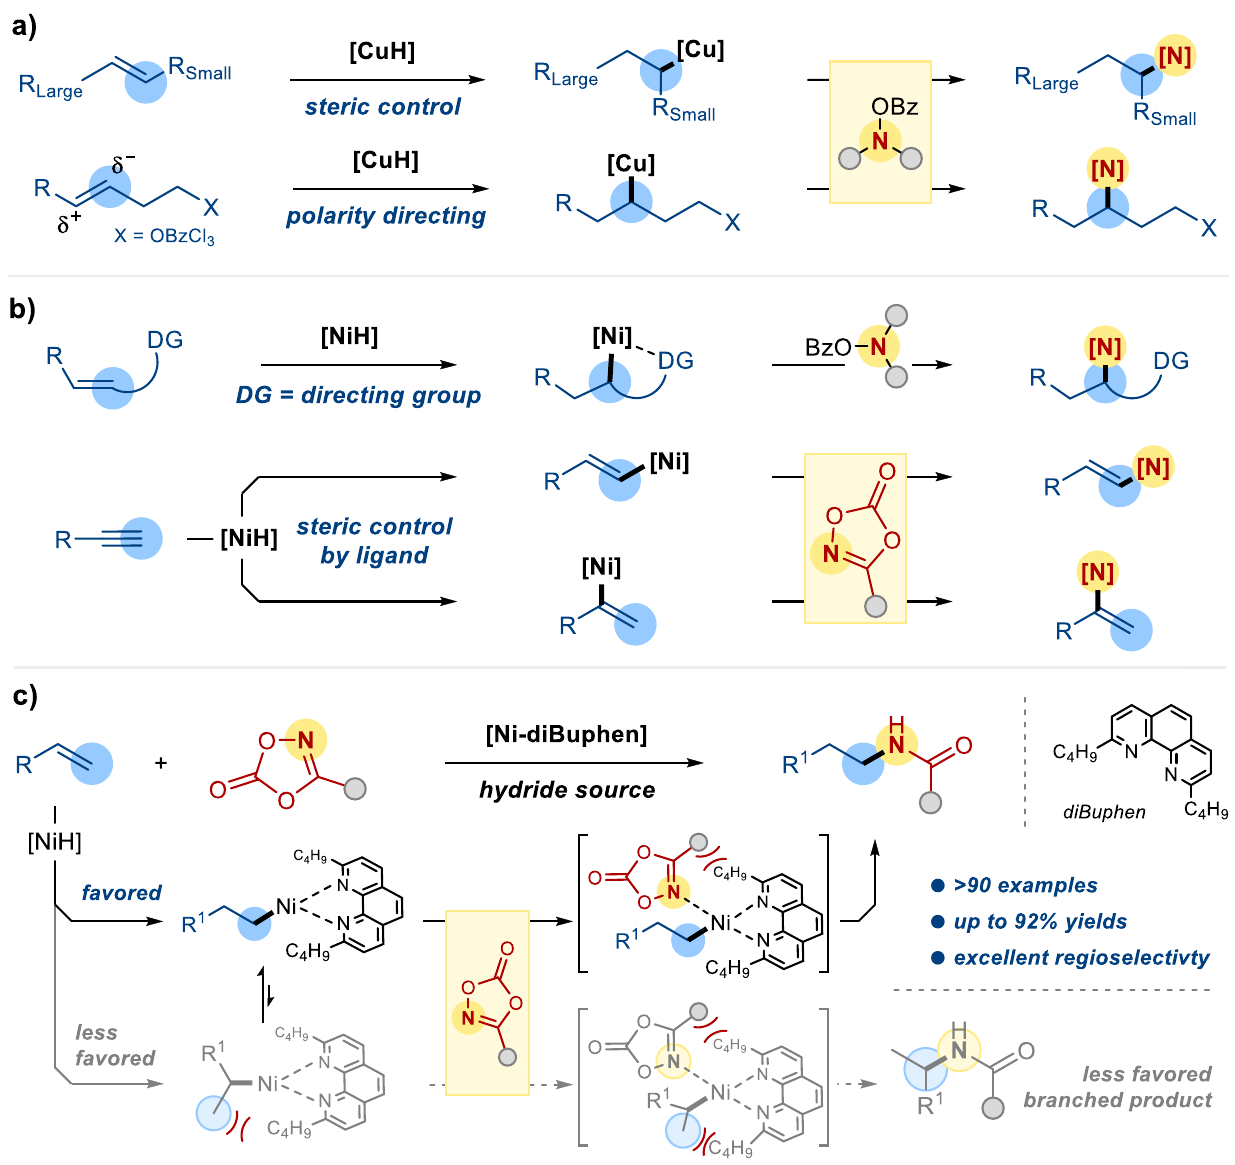
Fig. 1 Strategies for [M – H]-catalyzed regioselective hydroamidation reactions. a [CuH] mediated regioselective hydroamination. b [NiH] mediated regioselective hydroamination/hydroamidation. c This work: Ligand enhanced regioselective